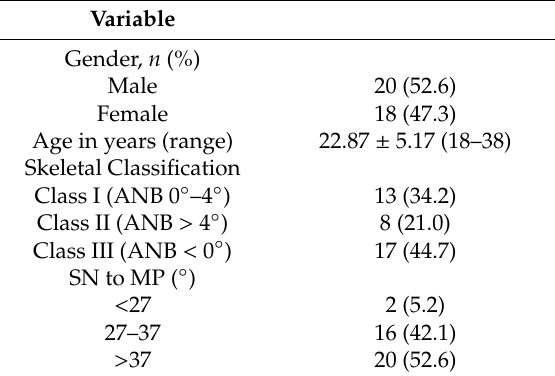
Table 1. Sample characteristics ( n = 38).